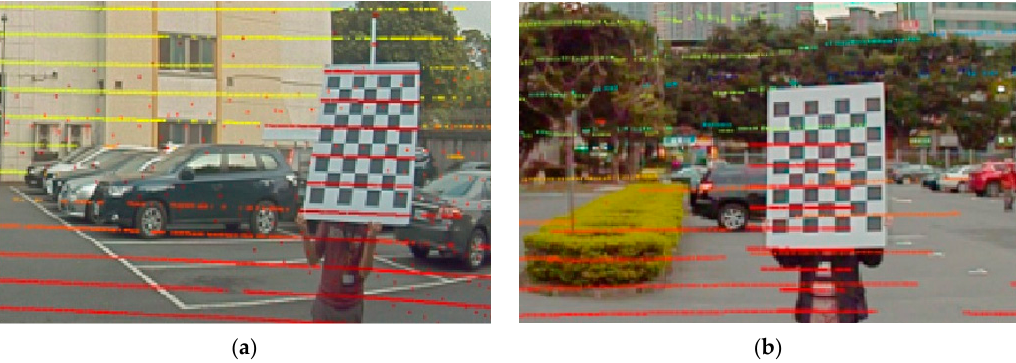
Figure 13. Calibration results: ( a ) desired, ( b ) unacceptable because of inaccurate translation and rotation matrices.